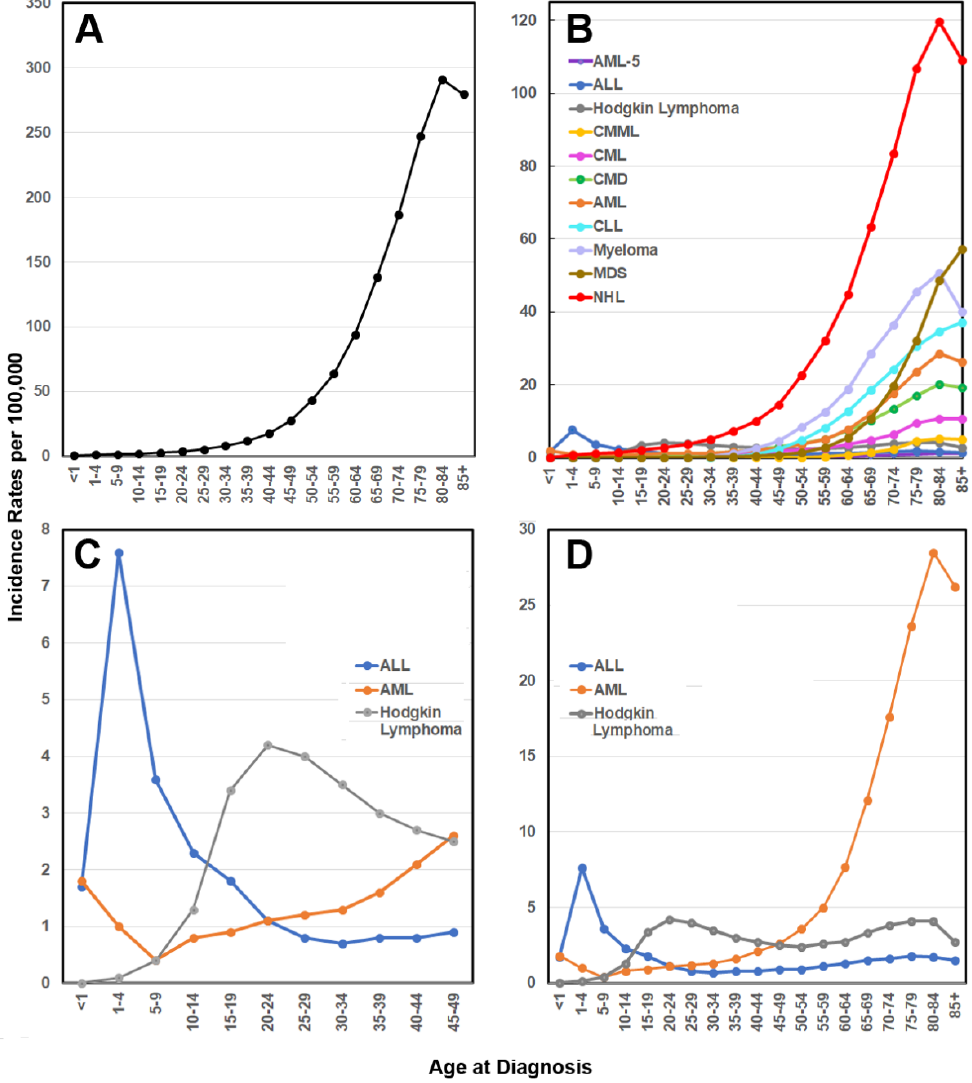
Figure 1. Incidence rates for hematological malignancies by age at diagnosis in the USA from 2014 to 2018 (https://seer.cancer.gov; accessed 28 November 2021) expressed per 100,000 individuals per annum. ( A ) Total cases. ( B ) Cases in A broken down into hematological malignancy subtypes. ( C , D ) Incidence of ALL, AML and Hodgkin lymphoma from birth to age 49 and 85+ respectively.